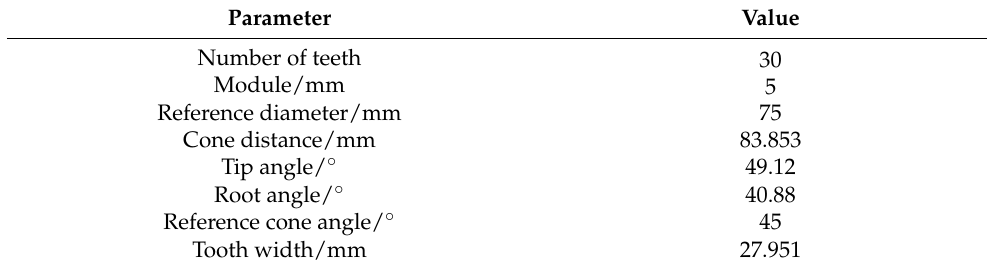
Figure 8. Gear to be evaluated. Table 2. Parameters of the measured gear.